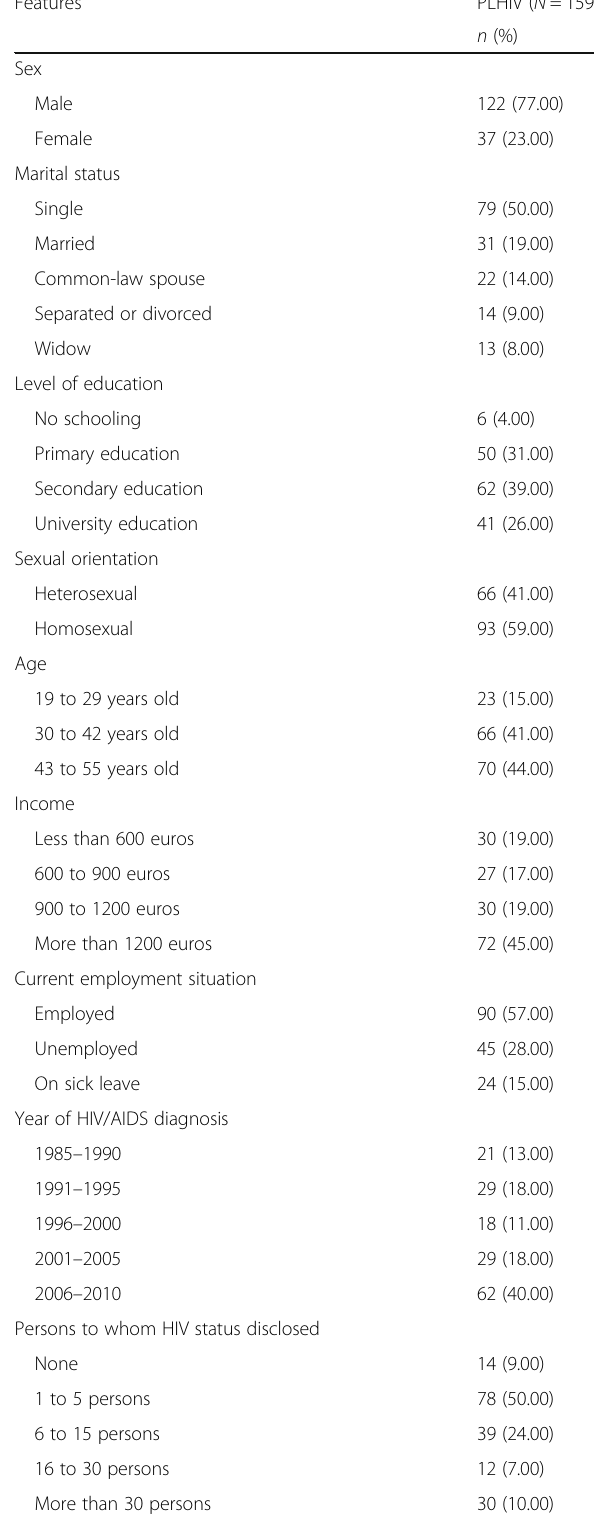
Table 1 Socio-demographic characteristics of participants